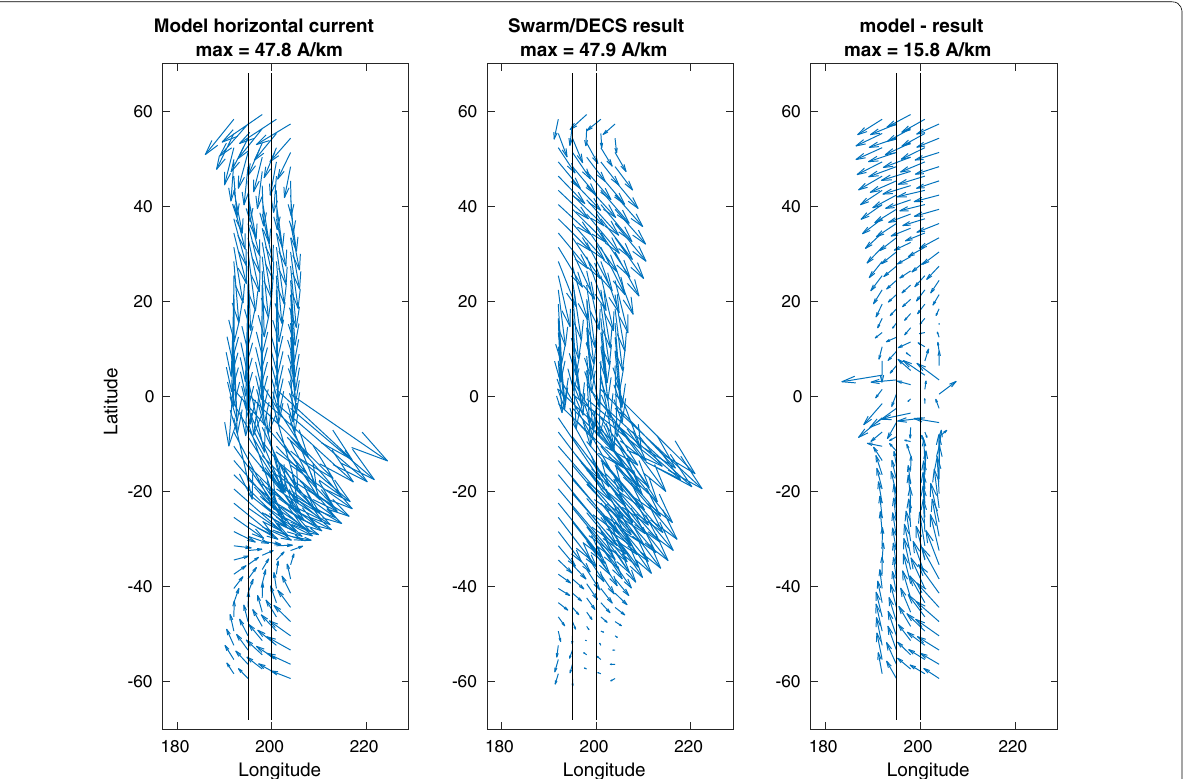
Fig. 4 Test T8. Map of the E-region horizontal current. From left to right: the TIE-GCM model current, result from the Swarm/DESC analysis, and the difference between the two. Same scale is used in each panel. Swarm-A/C orbits are shown as black lines. Compare with the latitude profiles shown in Fig.